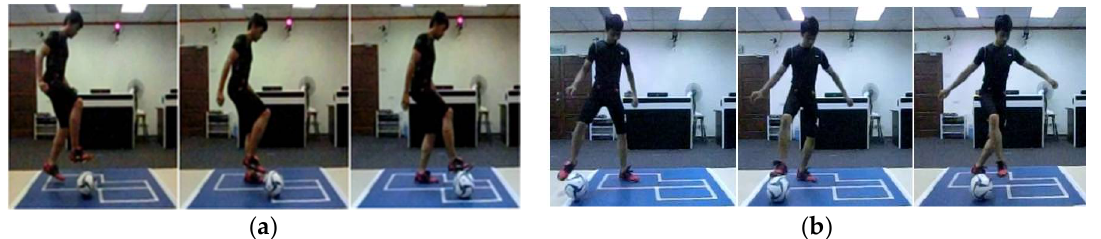
Figure 2. ( a ) Multi studded outsole-CTL-5TF (Admiral); ( b ) Non-marking outsole-CTL-5IC (Admiral).